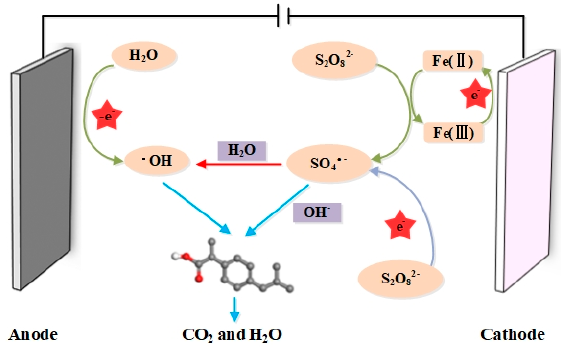
Figure 5. Reaction mechanism of the EC/Fe 3+ /PDS system .